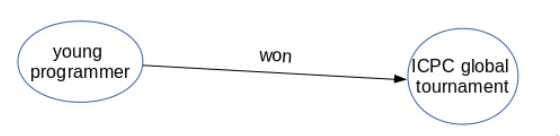
Figure 6. Knowledge Graph representation of the sentence: “The young programmer recently won the ICPC global